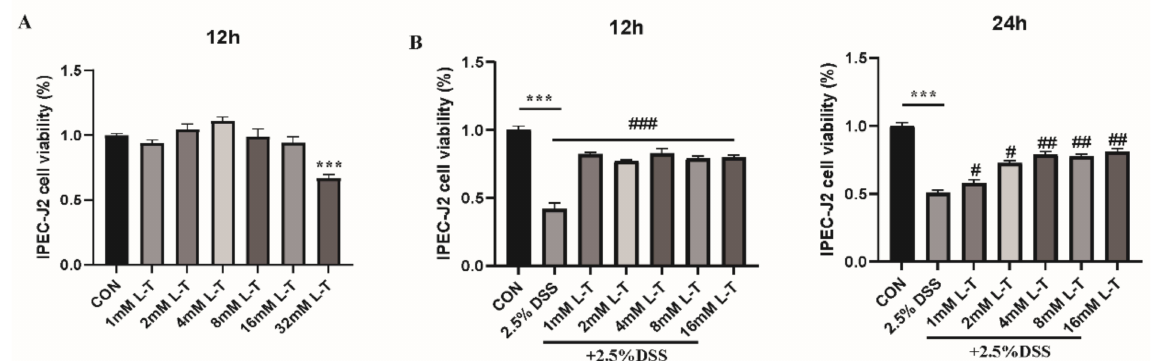
Figure 1. Effect of L-theanine on IPEC-J2 cells viability with/without DSS induction. ( A ) Cells were treated with the indicated concentrations of L-theanine for 12 h. *** P < 0.001, versus the CON group without L-theanine treatment; ( B ) Cells were pretreated with the indicated concentrations of L-theanine for 2 h and then stimulated with 2.5% DSS for 12 h and 24 h. The DSS group was obtained in the absence of L-theanine. *** P < 0.001, compared with the CON group. # P < 0.05, ## P < 0.01 and ### P < 0.001 versus DSS group. CON, DMEM without DSS and L-theanine; L-T, DMEM contained L-theanine; DSS, DMEM contained